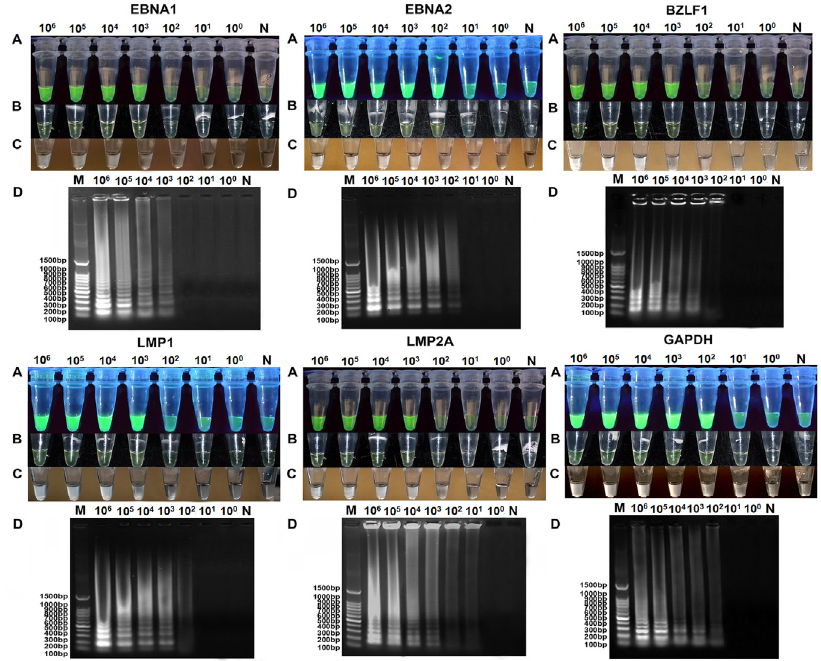
Figure 3. Detection limits of RT-LAMP assays for the evaluation of EBV latent transcripts (EBNA1, EBNA2, LMP1 and LMP2A), a lytic transcript (BZLF1) and GAPDH. The analytical sensitivity of RT-LAMP was determined using cell mixtures containing 1 × 10 6 BJAB cells and 10-fold serial dilutions of Raji cells ranging from 10 6 to 10 0 cells, untreated or treated with TPA. M, 100 bp DNA ladder; N, negative control; 10 6 –10 0